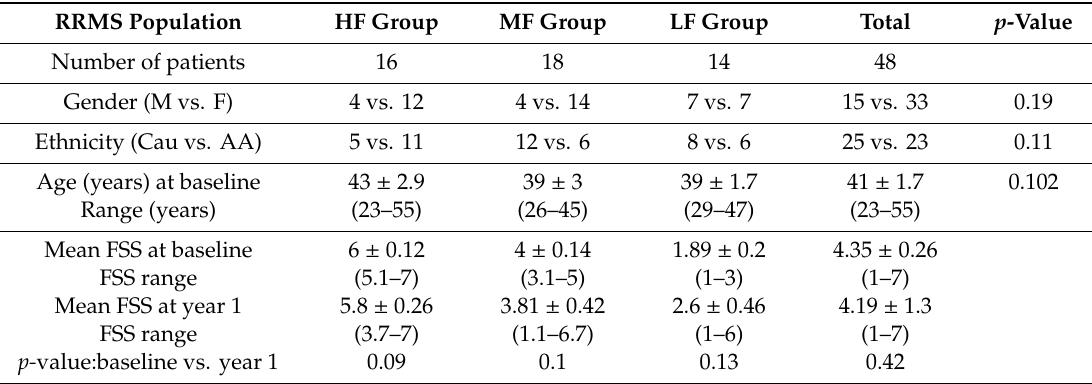
Table 1. Patients’ demographics and MRI